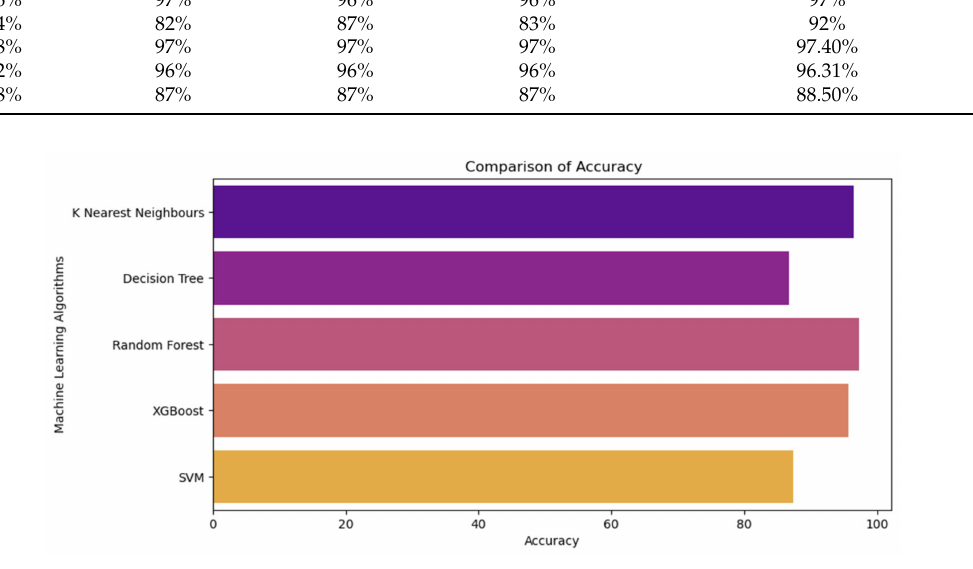
Figure 9. Accuracy comparison of ML